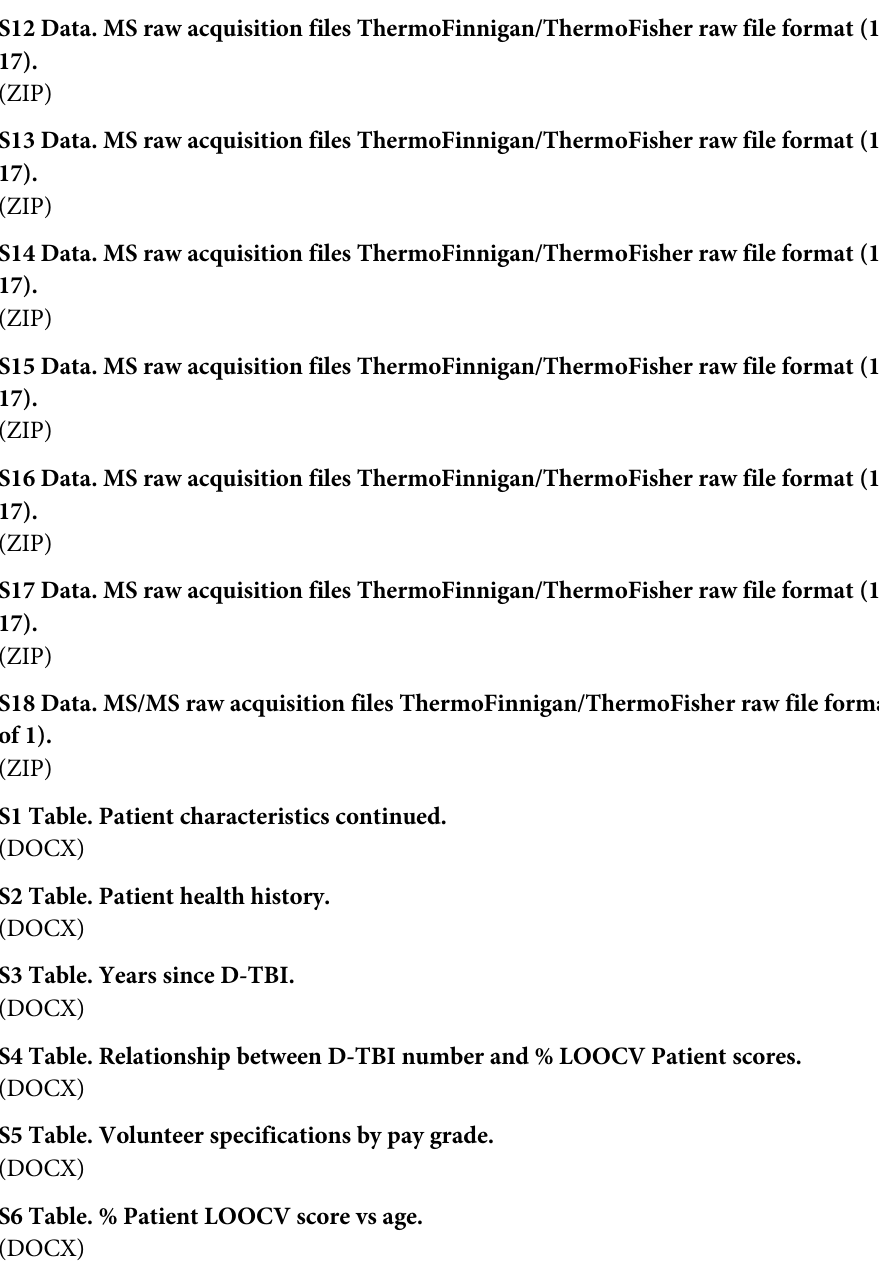
S1 Table. Patient characteristics continued. S2 Table. Patient health history. S3 Table. Years since D-TBI. S4 Table. Relationship between D-TBI number and % LOOCV Patient scores. S5 Table. Volunteer specifications by pay grade. S6 Table. % Patient LOOCV score vs age. S7 Table. Normalized peak area mean for each patient by m/Z used for figures and tables. (DOCX) S8 Table. Patient % classified LOOCV mass peak scores plotted in presented figures. S9 Table. Samples used in each figure. S10 Table. Mass peaks selected by LOOCV process. MS peaks used by figure